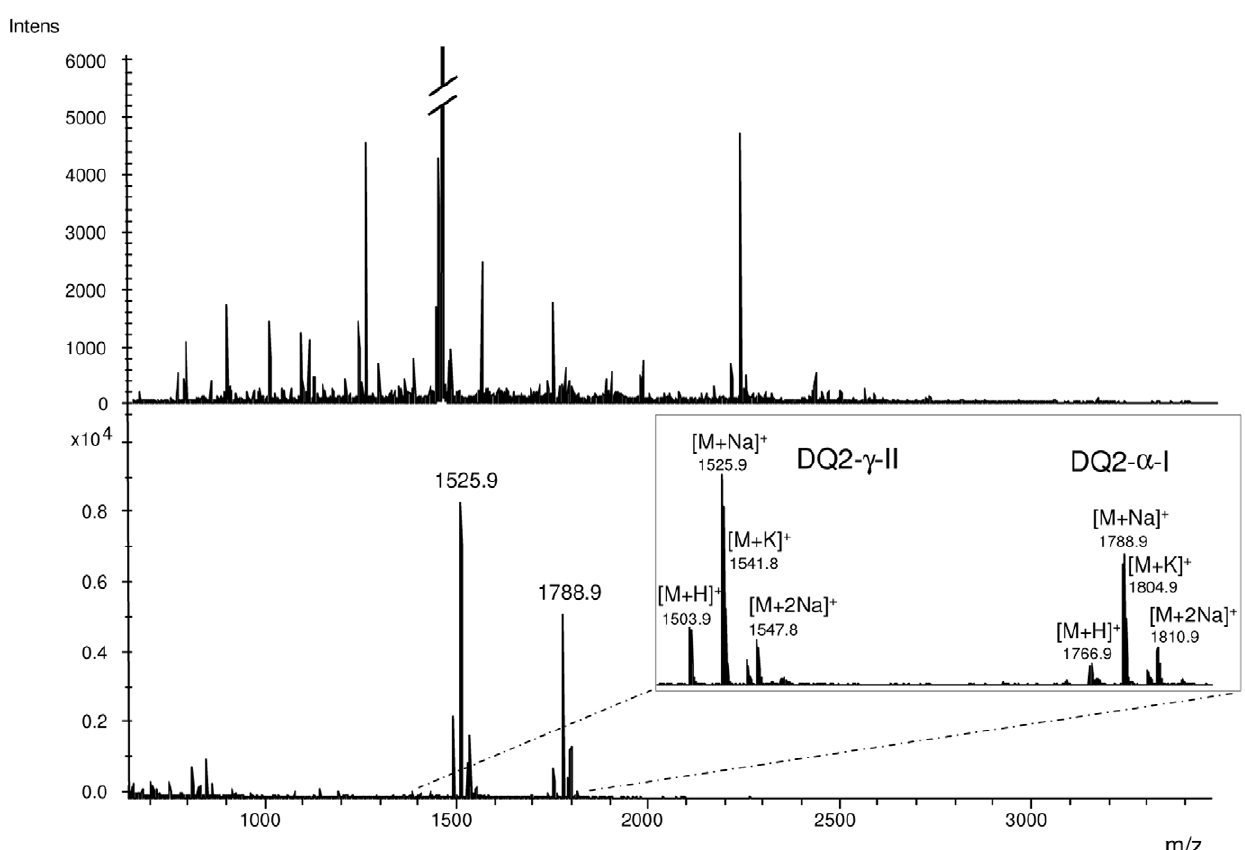
Figure 2. Specific enrichment of transamidated peptides. A PTCEC digest of whole gluten was spiked with the transamidated DQ2- a -I and DQ2- c -II peptides. MALDI-TOF spectra before (upper panel) and after enrichment (lower panel) are shown. The inset shows the four signals obtained for each of the two enriched peptides that correspond to the transamidated peptide, its sodium adduct, its potassium adduct and the adduct with two sodium ions, respectively. All signals observed in the lower mass range (up to m/z 900) were derived from matrix clusters.